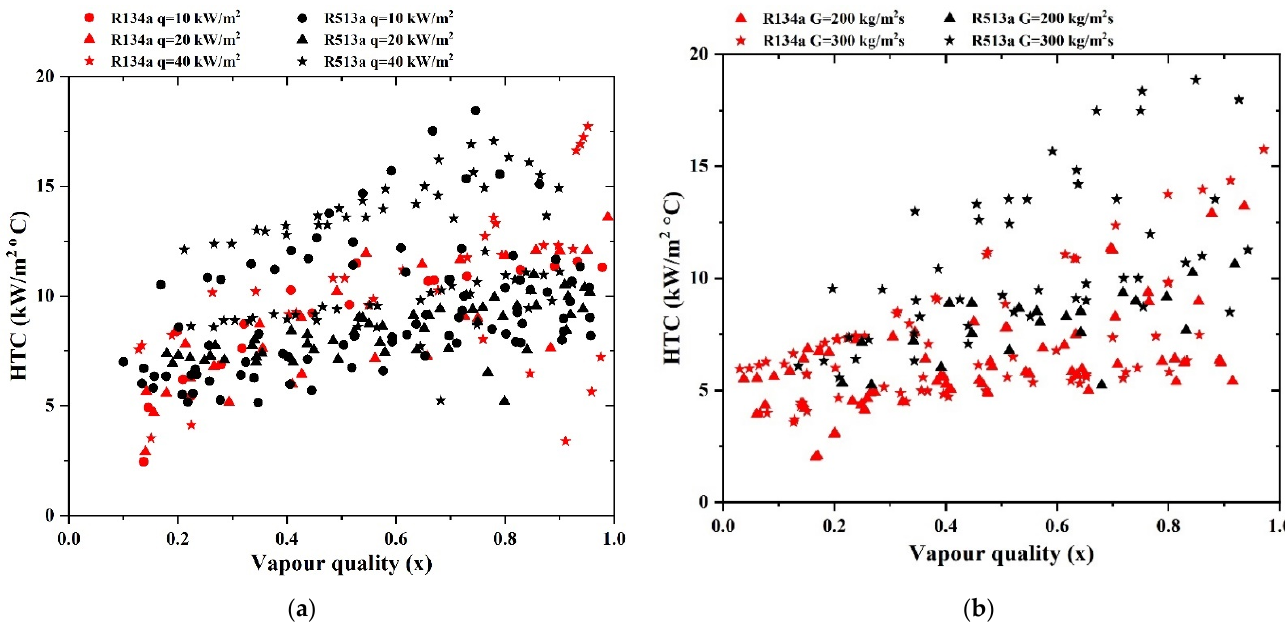
Figure 8. ( a ) Data comparison of R134a and R513a on different heat flux, i.e., 10, 20, and 40 kW/m 2 ; ( b ) Data comparison of R134a and R513a on different mass flux, i.e., 200 and 300 kg/m 2 s. Table 4. Comparison of experimental conditions of different authors regarding results shown above for refrigerants R134a and R513a in micro-finned tubes.